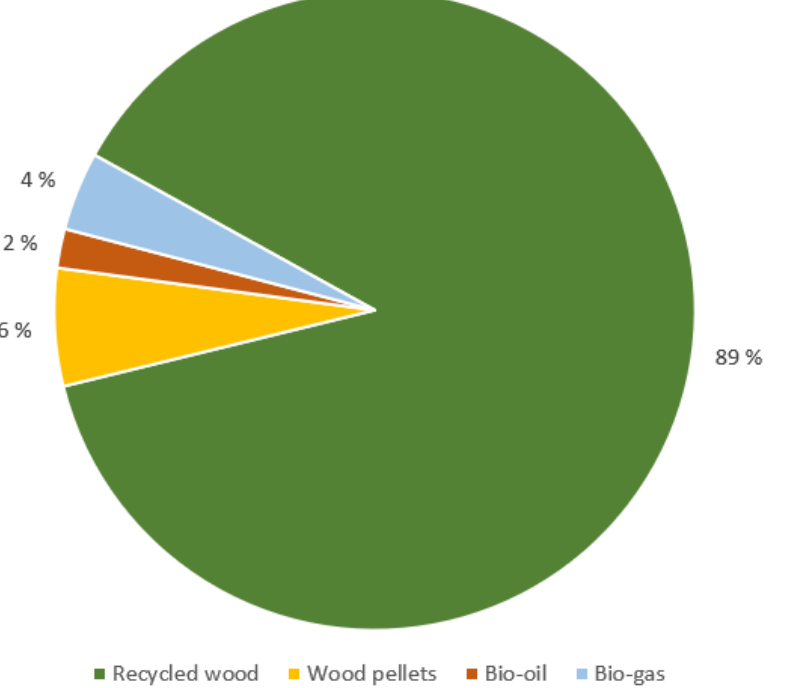
Figure 1. District heating fuel mass